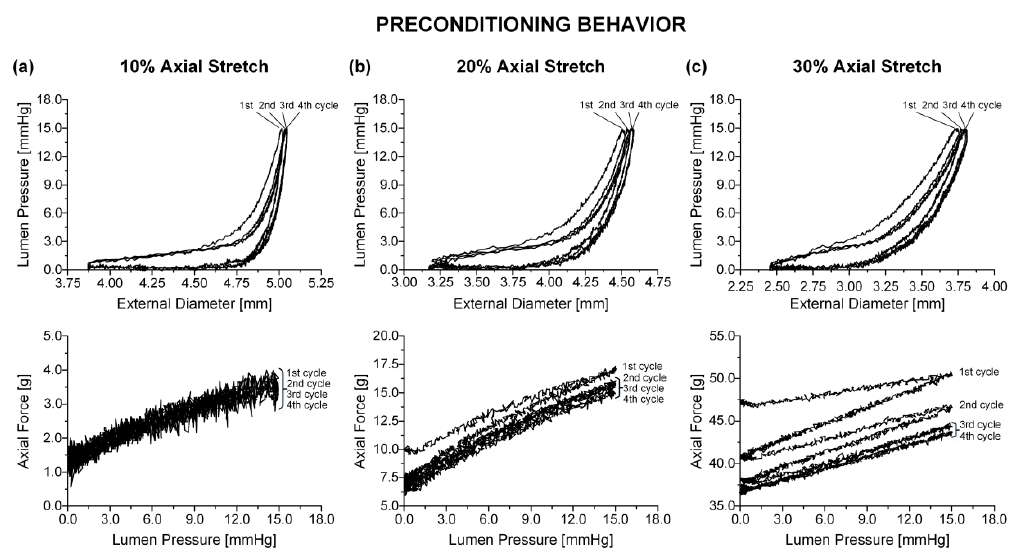
Figure 1. Online record of preconditioning for a distal duodenal specimen at ( a ) λ z = 1.1, ( b ) λ z = 1.2, and ( c ) λ z = 1.3. The 2nd, 3rd, and 4th pressure-diameter cycles overlapped and were enveloped by the larger 1st cycle. The area enclosed by the 1st and 2nd force-pressure cycles increased with increasing λ z , with all cycles overlapping at λ z = 1.1 and the 3rd and 4th cycles being very slim and nearly overlapping at λ z = 1.2 and 1.3.